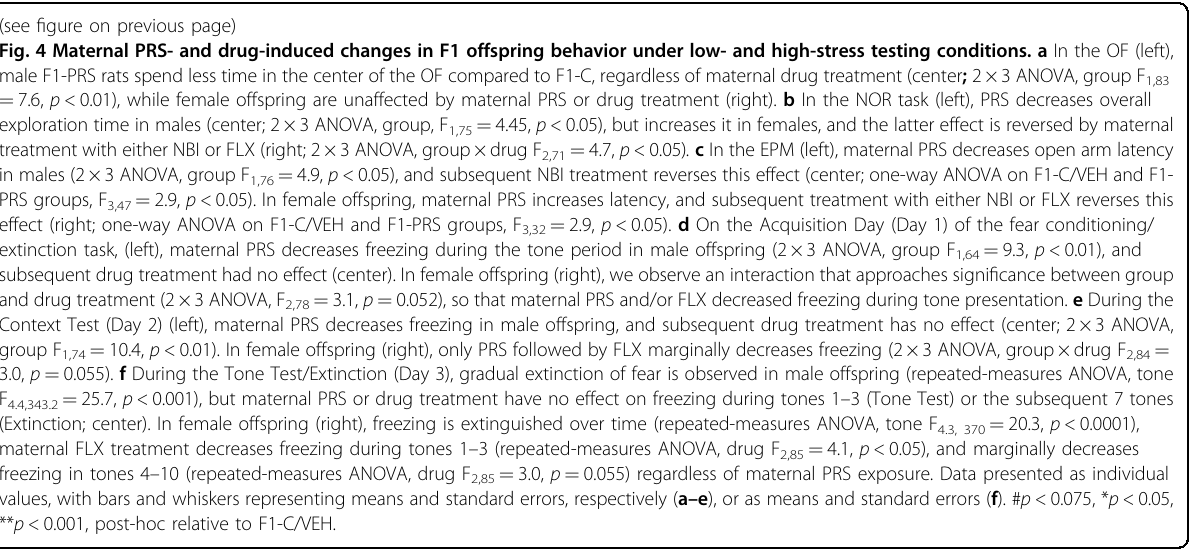
(Fig. 4f, center). Female F1-FLX rats froze less than F1- VEH and F1-NBI rats, regardless of maternal PRS, during tone recall and extinction (Fig. 4f, right). No maternal PRS effects were observed on Day 4 or 5 (see SI). F2 neonates: basic attributes Naïve female rats mated with F1-PRS males gained more weight during pregnancy and weighed more than those mated with F1-C males 30 days after parturition (Table S7), although there were no differences in litter size or pup weight (Table S8). F2 adults: behavior Behavioral analysis in adult F2 offspring revealed that in most tasks, grandmaternal PRS affected female, but not male, offspring. In the OF, PRS induced higher locomo- tion during the fi rst 5 min in F2 female offspring; no